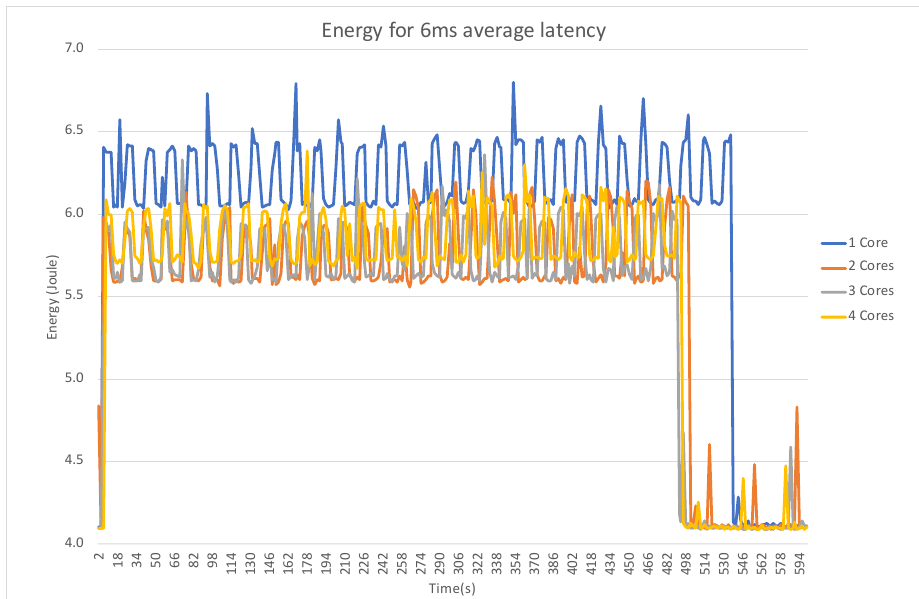
Figure 12. Energy consumed during the last second that proceeds the measurement for different number of cores during network average latency test with 6 ms